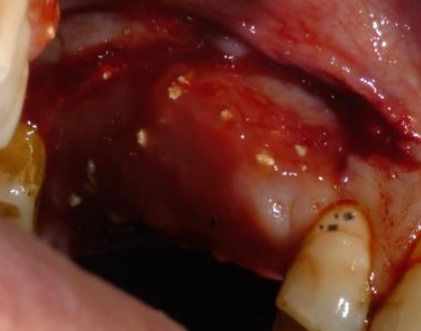
Figure 8. View of the newly formed tissue at the time of removal of the barrier. The granules of beta tricalcium phosphate can still be observed.